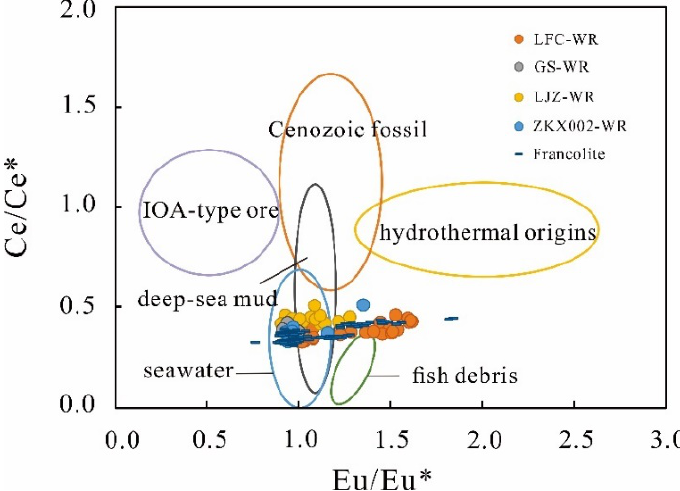
Figure 10. Ce and Eu anomalies of various sources of apatite. The involved REY were normal- ized by PAAS and were calculated as follows: [Ce/Ce*] N = Ce N /(La N 1/2 × Pr N 1/2 ), [Eu/Eu*] N = Eu N /(Sm N 1/2 × Gd N 1/2 ). For the data of Cenozoic fossils, REY were calculated as [Ce/Ce*] N = Ce N /(La N 2/3 × Nd N 1/3 ), [Eu/Eu*] N = Eu N /(Sm N 2/3 × Tb N 1/3 ). The data are from reported REY, including: Cenozoic fossils [54], apatite in deep-sea mud from the Pacific Ocean [8], seawater from the Pacific and the Atlantic Oceans [72], fish debris [88], apatite from IOA (iron oxide